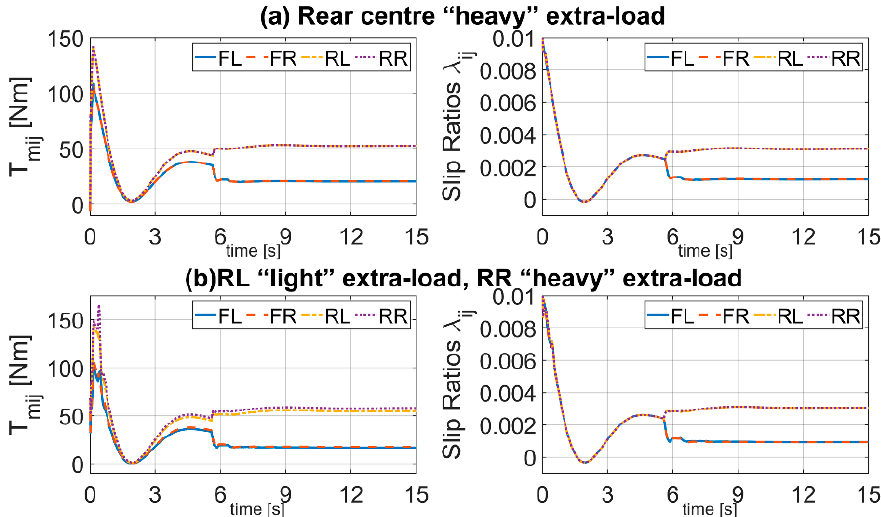
Figure 16. SV Equalization: 4IWM torques and slips coordination.